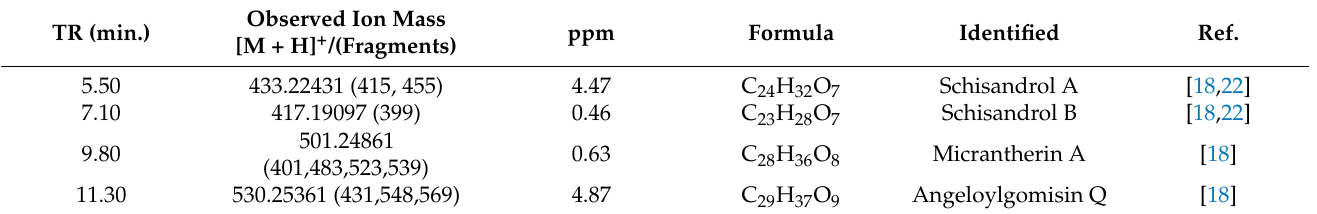
Table 2. MS data of lignans identified in S. chinensis fruits extract at positive ionization mode. TR (min.)